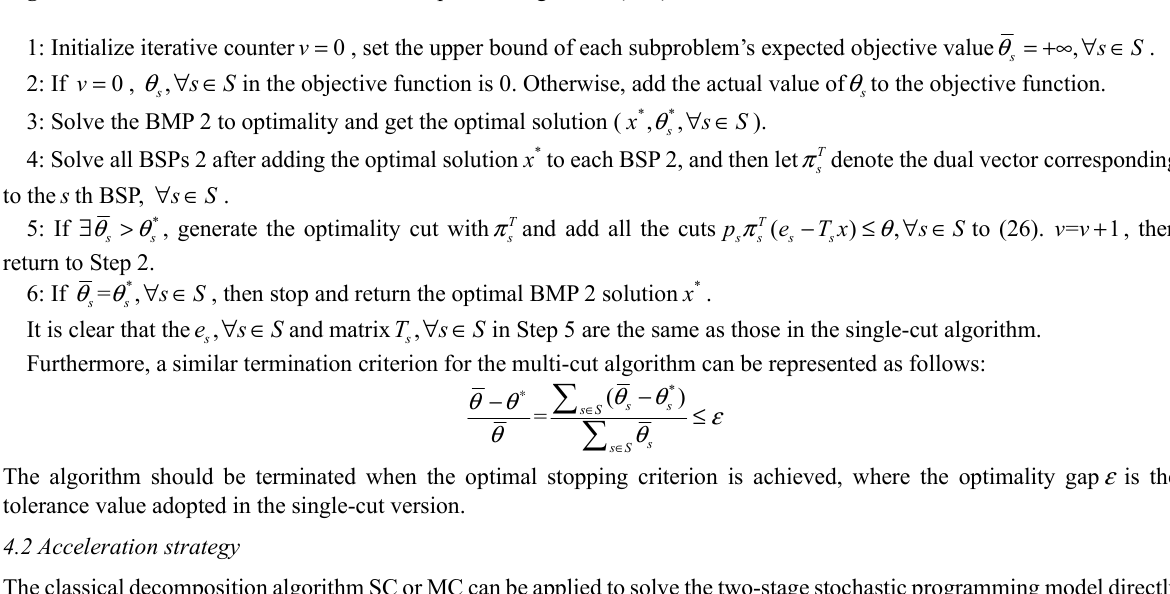
Algorithm 2. Multi-cut based Benders decomposition algorithm